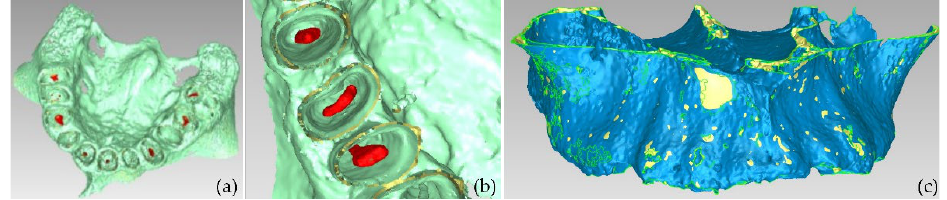
Figure 10. Segmentation results for Experiment 3 after the application of the “Grow from seeds” method, superimposed over CBCT slices in the axial plane ( a ), the coronal plane ( b ), and the sagittal plane ( c ).